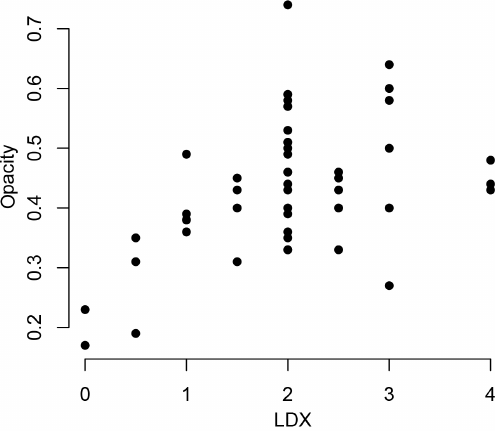
Figure 9. Shell condition of Heliconoides inflatus , ranked on the Li- macina Dissolution Index (LDX), plotted against shell condition of the same shells quantified using the opacity scale. LDX and opac- ity are positively correlated until LDX scores of 2, at which point there is no correlation between LDX and opacity. This breakdown is likely due to the changes in surface texture of the pteropod shell from shiny to matte. The texture change linked to dissolution is a factor when assigning values on the LDX scale, but as the color and opacity do not change, it is not detected by the opacity